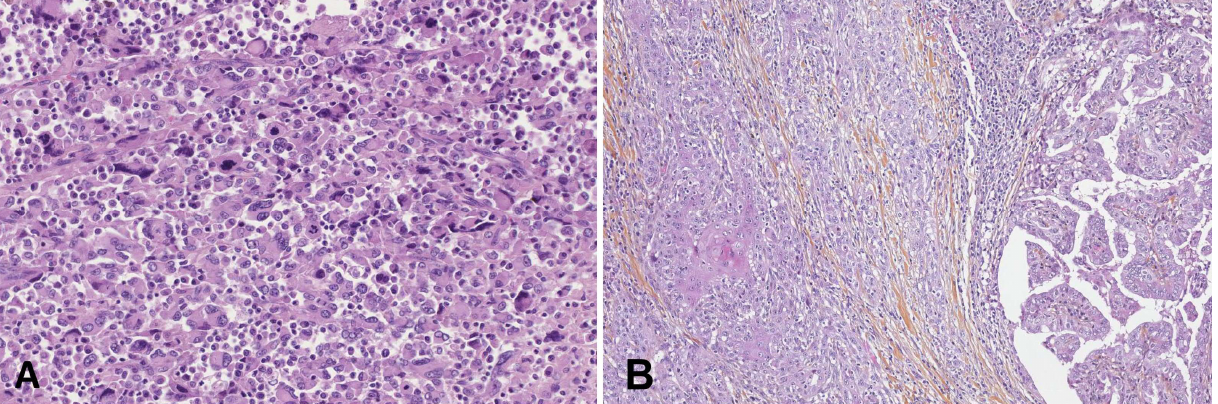
Figure 2. ( A ) ATC pleomorphic variant: atypical cells with abundant inflammatory infiltrate (×400 magnification). ( B ) Tall cell papillary carcinoma (right) transformated in ATC squamoid variant (left) (×100 magnification).